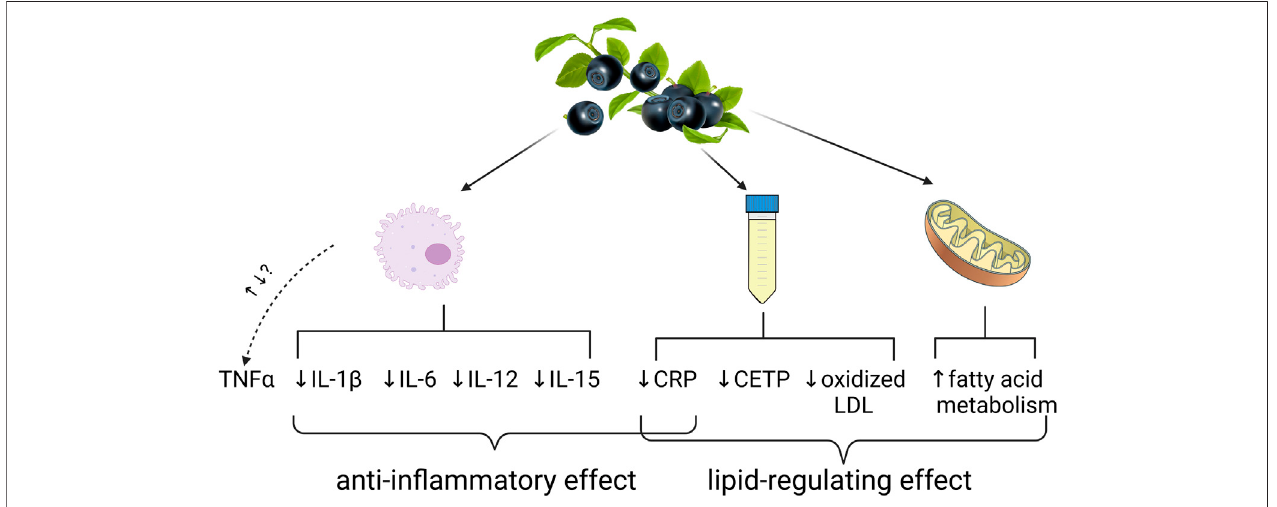
FIGURE 5 | A summary of the theorized mechanisms of action of bilberry fruits and extracts in the treatment of in fl ammatory diseases and dyslipidemias.